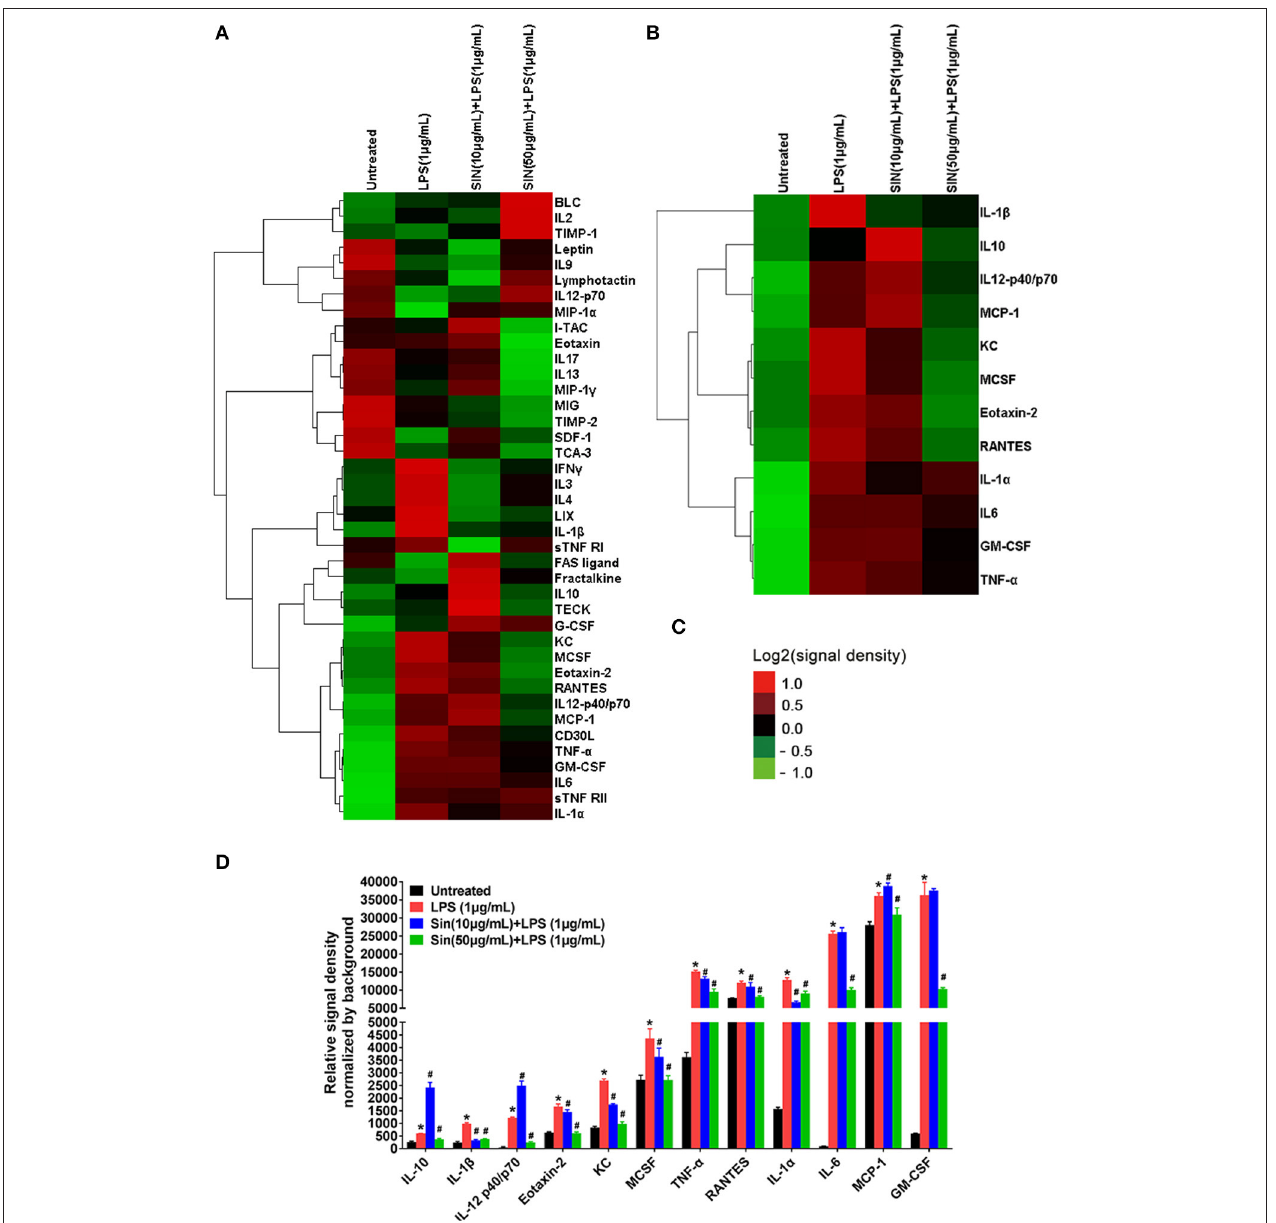
FIGURE 2 | Hierarchical cluster of cytokines in the inflammatory array and the 12 cytokines which were significantly regulated by SIN (at least one comparison P < 0.05, 10 µ g/mL SIN + LPS vs. LPS or 50 µ g/mL SIN + LPS vs. LPS). (A) Hierarchical cluster of the 40 cytokines. (B) Hierarchical cluster of the 12 selected secreted cytokines (IL-6, GM-CSF, IL-12 p40, IL-1 α , TNF- α , IL-1 β , KC, Eotaxin-2, IL-10, M-CSF, RANTES, and MCP-1). (C) Color bar of the cluster analysis. Red, upregulated; green, downregulated. All the signal density values of cytokines were transformed to Log 2 (signal density) and subtracted the density value-wise mean from the values of each cytokine, so that the mean value of each group was 0. Multiply all values in each group of data by scale factor S, so that the sum of the squares of the values in each row is 1.0. Cluster type, average linkage clustering. Figures were generated by Cluster 3.0 (Stanford University) and TreeView (Alok, version: 1.1.6r4). (D) Detailed relative signal density normalized by background of 12 selected cytokines. (* P < 0.05 vs. untreated; # P < 0.05 vs. LPS treated RAW264.7).